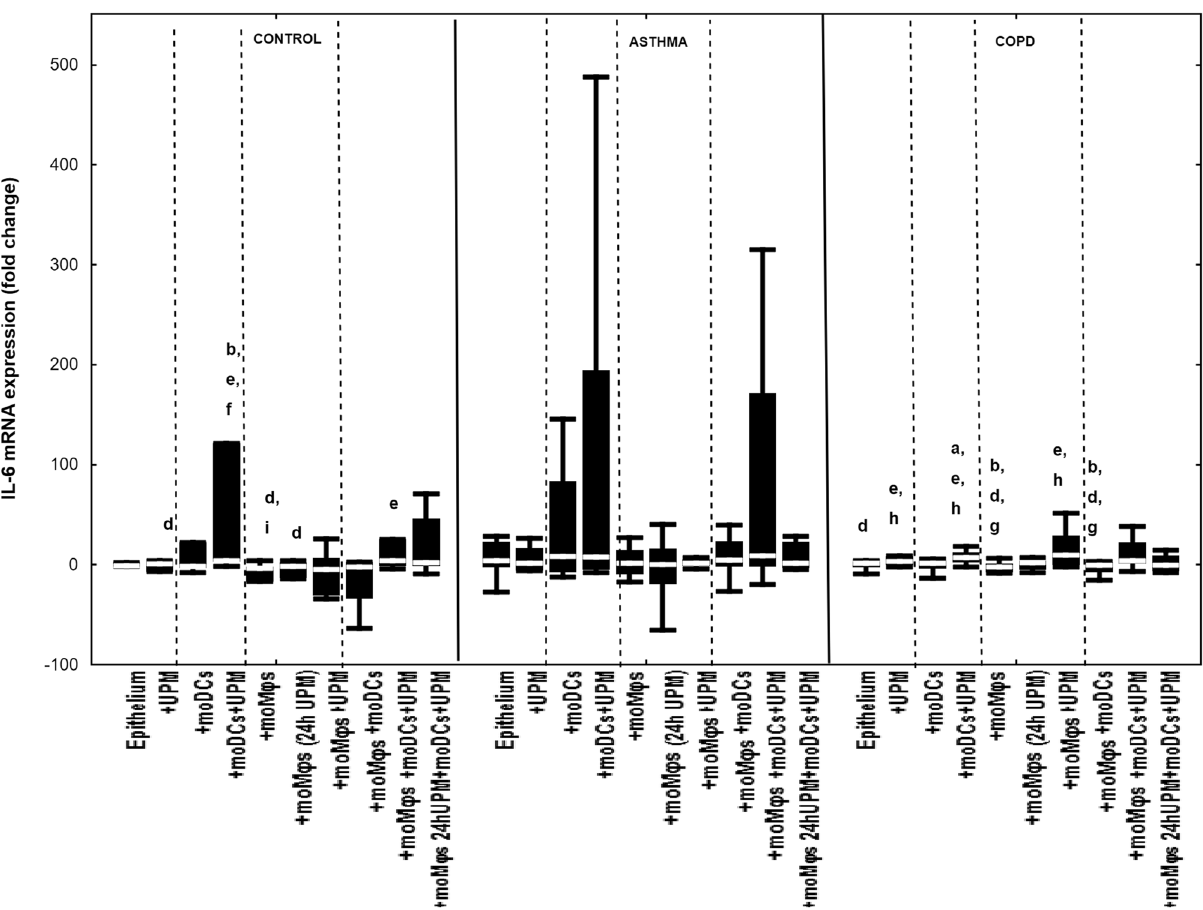
Figure 3. IL-6 mRNA expression in air–liquid interface (ALI) after 24 h UPM exposure in multi co-culture schemes in control subjects, asthma and COPD patients. The data are shown as non-outlier range (whiskers), interquartile range (box) and median (line); p value calculated using Mann–Whitney U test. The p value < 0.05 in comparison to: a—epithelium, b—epithelium + UPM, c—epithelium + moDCs, d—epithelium + moDCs + UPM, e—epithelium + moMφs, f—epithelium + moMφs (24 h UPM), g— epithelium + moMφs + UPM, h—epithelium + moMφs + moDCs, i—epithelium + moMφs + moDCs + UPM, j—epithelium + moMφs (24hUMP) + moDCs + UPM; ^ asthma versus control, # COPD versus control, *asthma versus